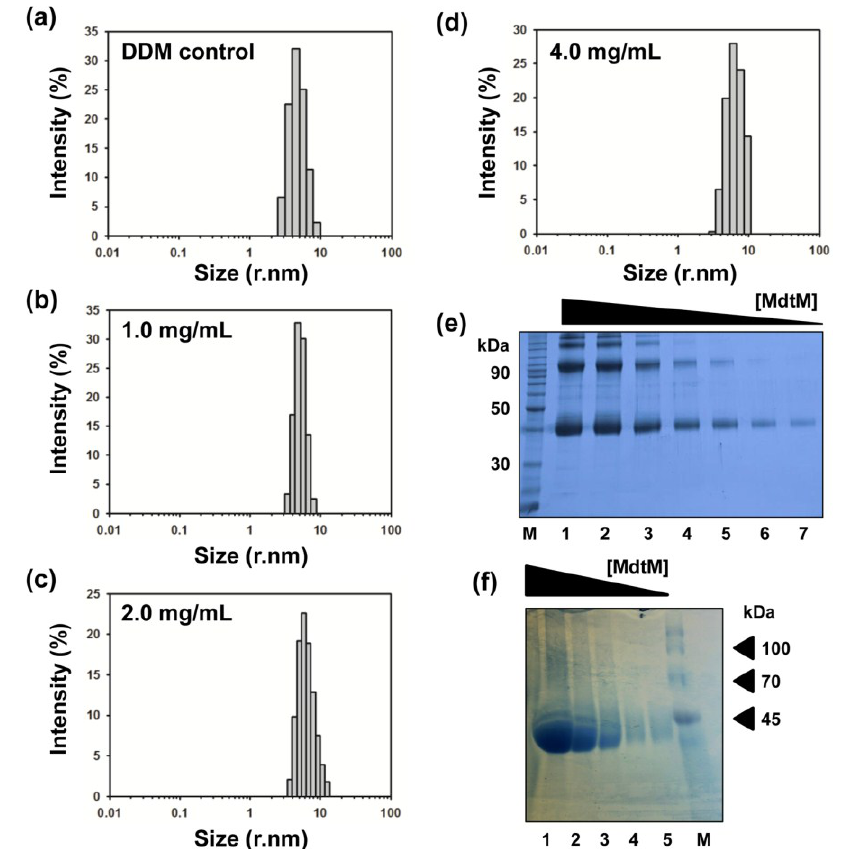
Figure 5. Oligomeric state of MdtM . Size distribution by intensity of ( a ) DDM-buffer solution alone, and ( b ) 1.0 mg/mL; ( c ) 2.0 mg/mL; and ( d ) 4.0 mg/mL of MdtM-DDM protein-detergent complex solution as determined by dynamic light scattering measurements; ( e ) Concentration dependent oligomerization of MdtM on SDS-PAGE. Lanes 1–7 contained 16 µg, 8 µg, 4 µg, 2 µg, 1 µg, 0.5 µg and 0.25 µg of MdtM protein, respectively. The lane labelled (M) contained molecular weight marker. Samples were run on a 15% SDS-PAGE gel and Coomassie stained. ( f ) Blue native PAGE of purified MdtM. Lanes 1–5 contained 33 µg, 11 µg, 3.7 µg, 1.2 µg and 0.4 µg of purified protein, respectively. The lane labelled (M) contained molecular weight marker. Samples were run on a BN-PAGE gradient gel of 3%–18% acrylamide and